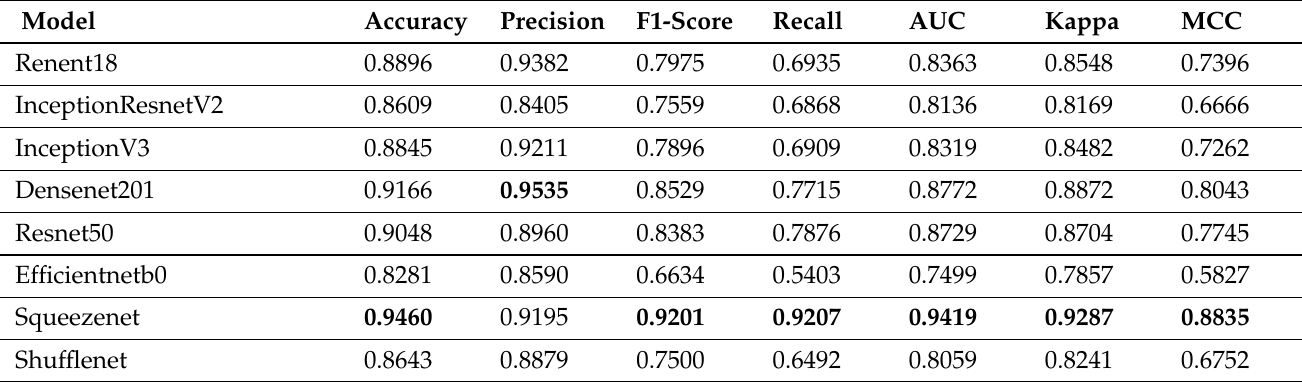
Table 9. Binary (benign vs. malignant) classifier performance: comprehensive table of metrics for classifying a combined pool of all histopathological image magnifications (40 × , 100 × , 200 × , and 400 × ) extracted using a single state-of-the-art baseline CNN model.